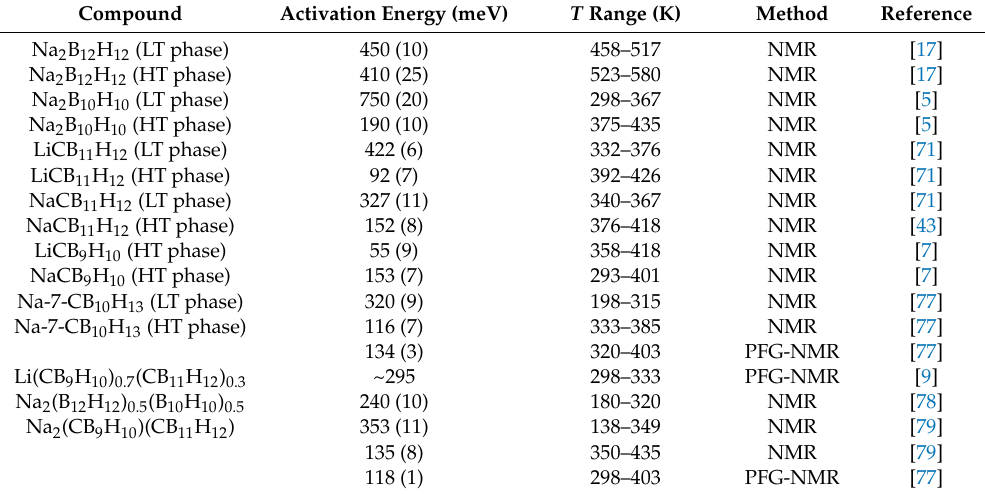
Table 2. Activation energies for translational di ff usion of Li + and Na + ions in closo - and nido -hydroborate salts, as derived from NMR and PFG-NMR